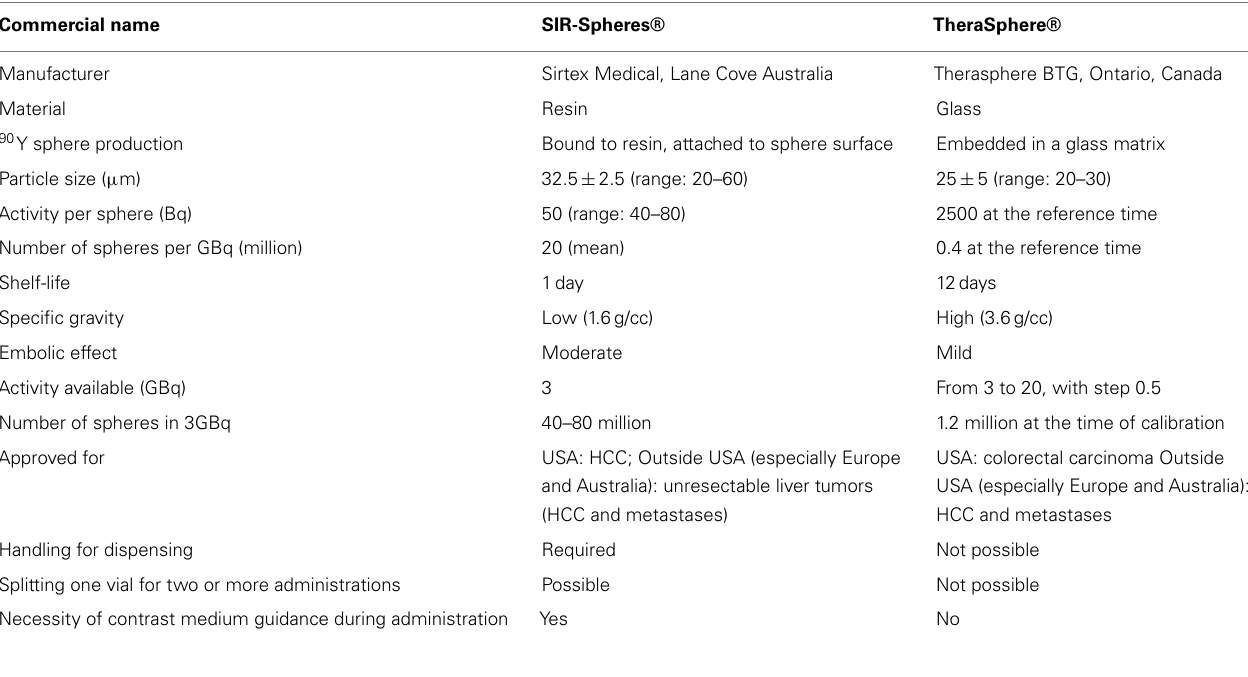
Table 1 | Characteristics of 90 Y-microspheres (6, 20, 24)